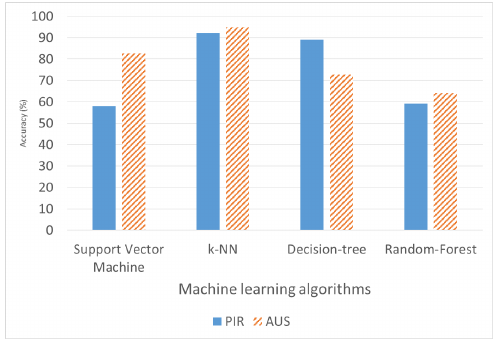
Figure 4. Accuracies of different ML algorithm for AUS and PIR sensor